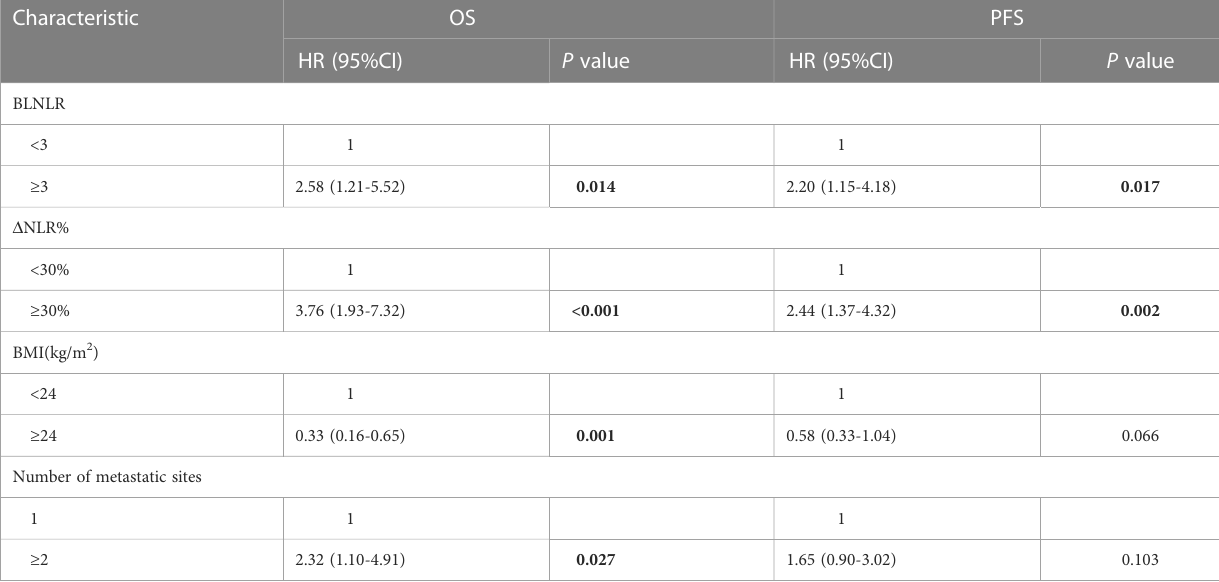
TABLE 3 Multivariate Cox regression model on overall survival and progression-free survival. Characteristic